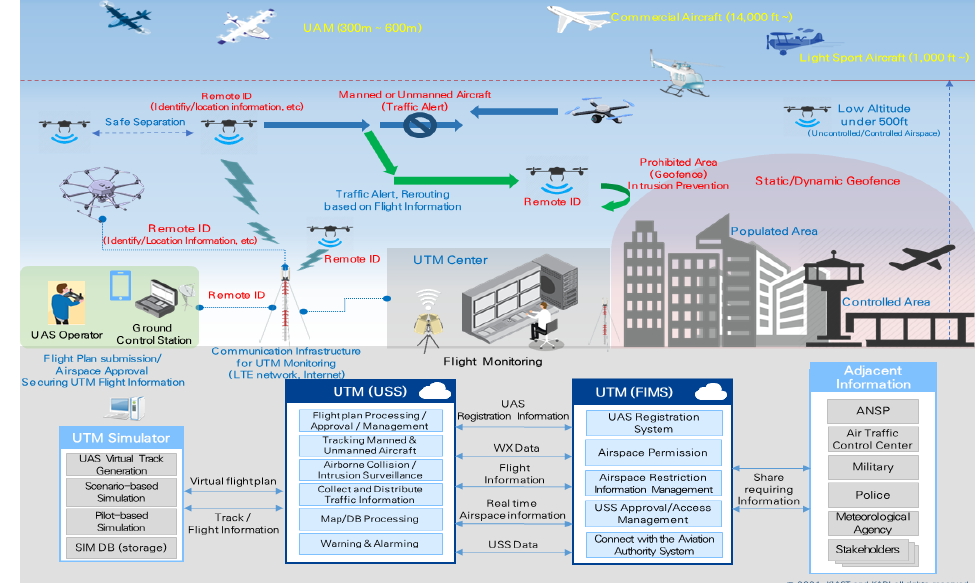
Figure 1. Operation Range and Concept of UTM in Korea.